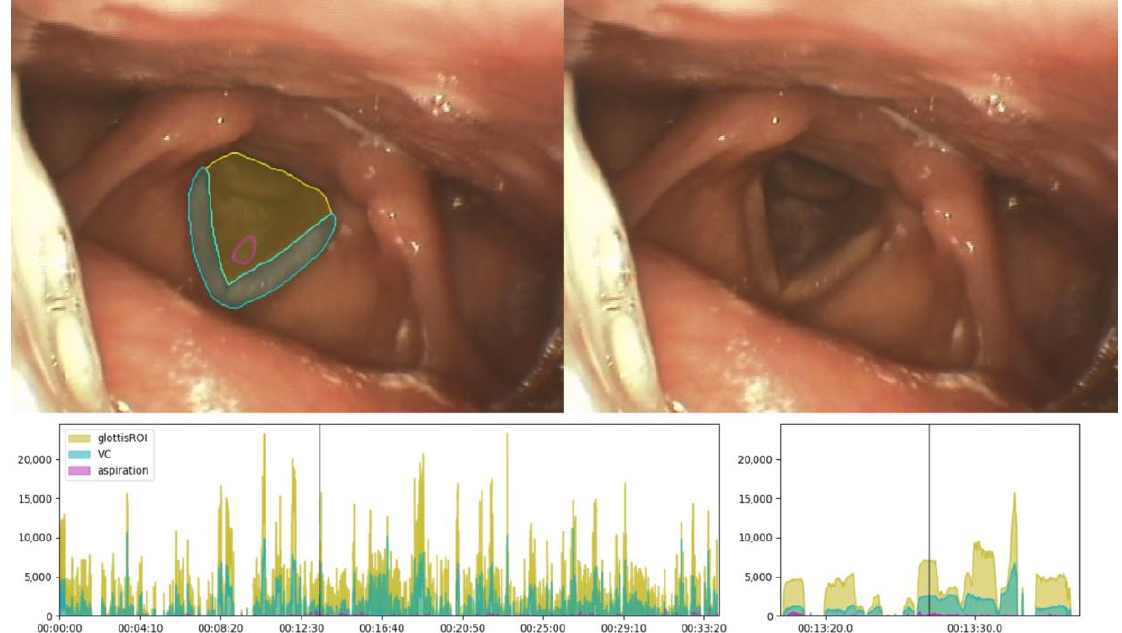
Figure 7. Visual aids to find meaningful frames for interpretation of model output. Screenshot of AI-based segmentation and detection of aspiration results (upper left), respectively, and normal view (upper right). Timeline and timeline zoom with a curve displaying the number of pixels for the segmentation tasks and the detected aspiration (below). Vertical line indicates the point in time.